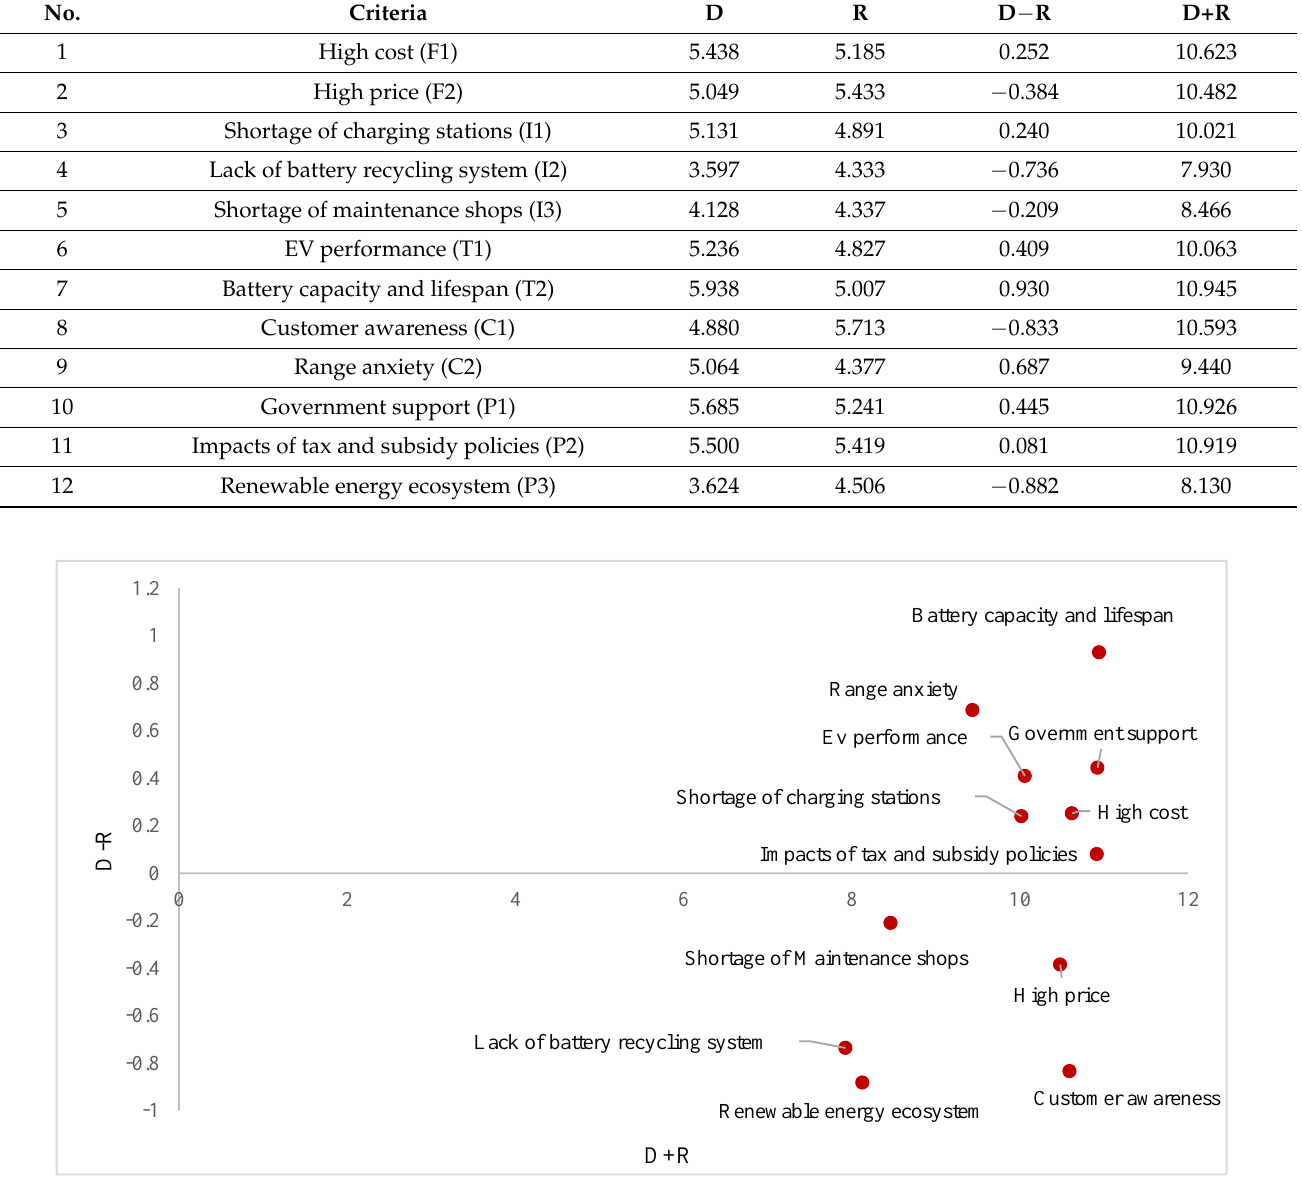
Figure 2. The casual diagram.